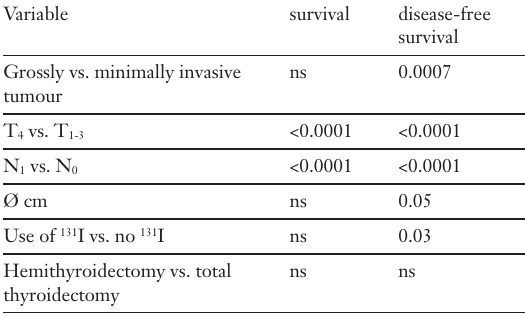
Cause-specific survival rates in subgroups of FTC. ( ) = patients at risk.